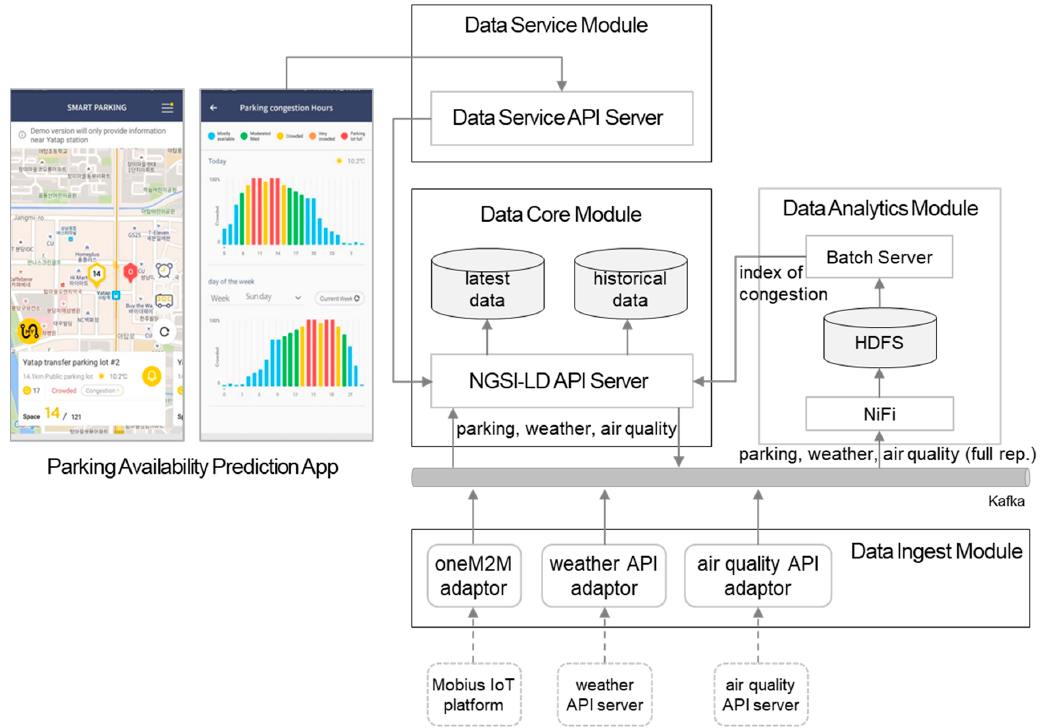
Table 4. A list of data models for parking service.